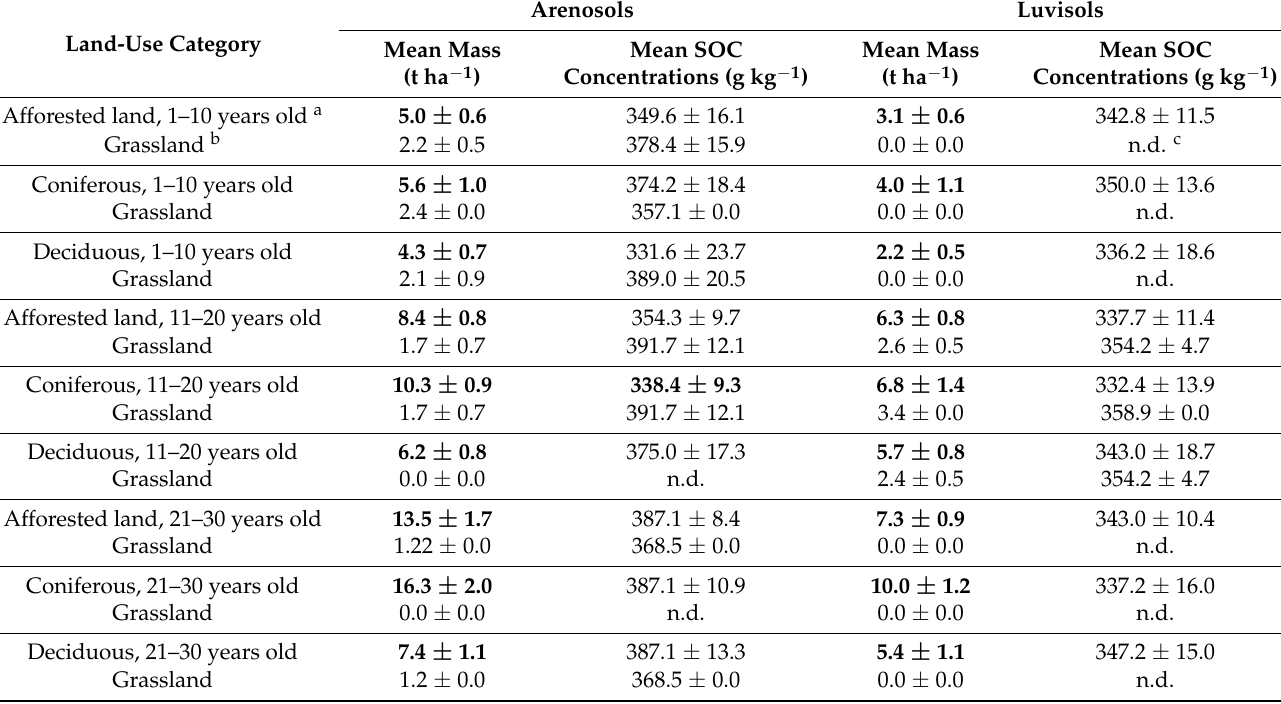
Table 2. Mean mass of forest floor (OL + OF + OH) and plant litter in perennial grassland and mean soil organic carbon (SOC) concentrations in afforested land and grassland of Arenosols and Luvisols [47]. Bold values denote statistical significance between the values in afforested land, coniferous or deciduous and the values in grasslands at the p < 0.05 level. Arenosols Luvisols Land-Use Category Mean Mass Mean SOC (t ha − 1 ) Concentrations (g kg − 1